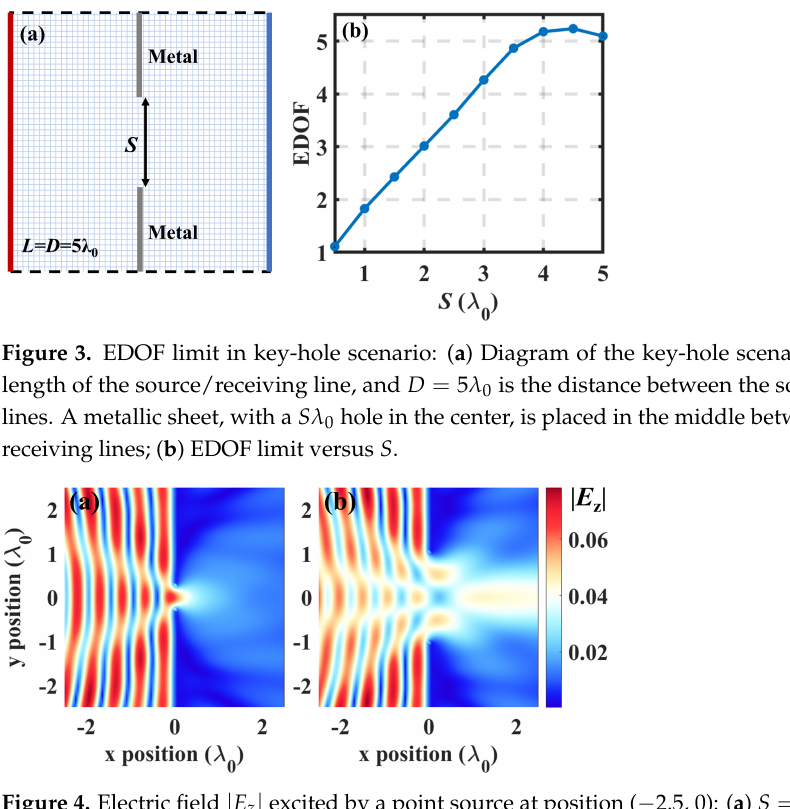
Figure 4. Electric field | E z | excited by a point source at position ( − 2.5, 0): ( a ) S = 0.5 λ 0 ; ( b ) S = 2 λ 0